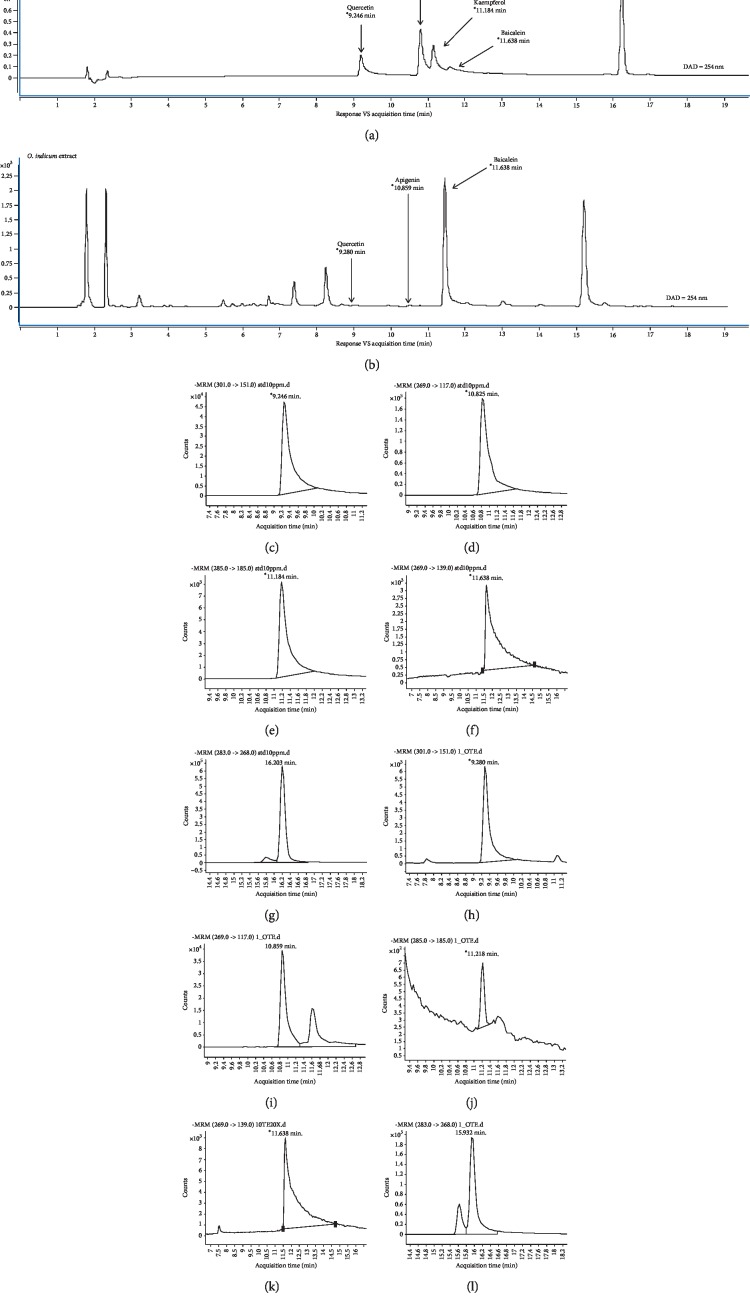
Multiple reaction monitoring (MRM) chromatograms of Oroxylum indicum extract. (a) Standard reference compounds. (b) Mixtures of standard reference compounds. (c) Mass spectra of quercetin. (d) Mass spectra of apigenin. (e) Mass spectra of kaempferol. (f) Mass spectra of baicalein. (g) Mass spectra of biochanin A. (h–l) Individual mass spectra of Oroxylum indicum extract at different retention time periods corresponding to the mass spectra of quercetin, apigenin, kaempferol, baicalein, and biochanin A, respectively.